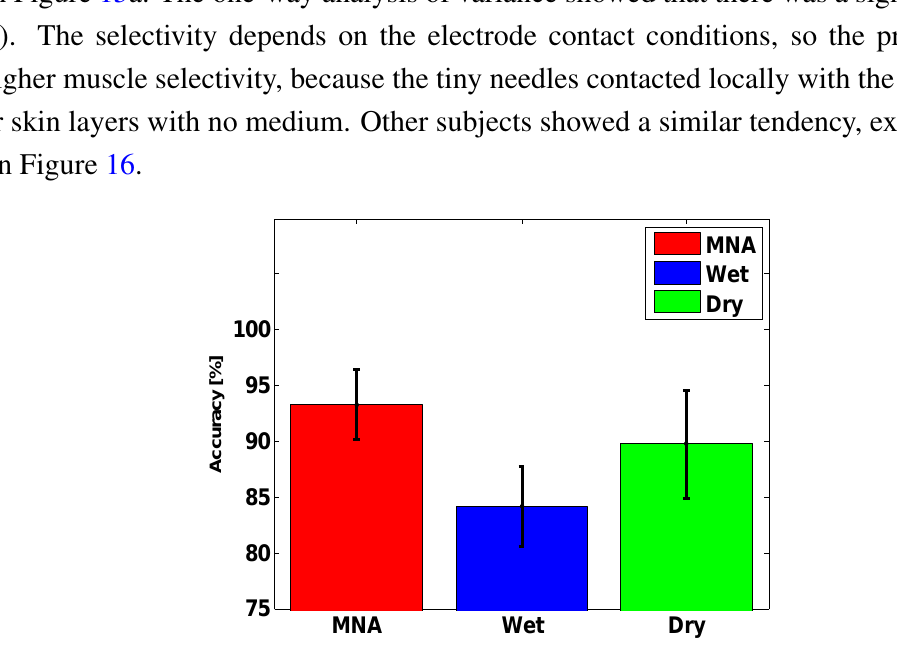
Figure 14. Mean accuracy and standard deviation of the classification accuracy using three types of electrodes (Subject 1). The accuracy of the proposed MNA electrode was significantly higher.